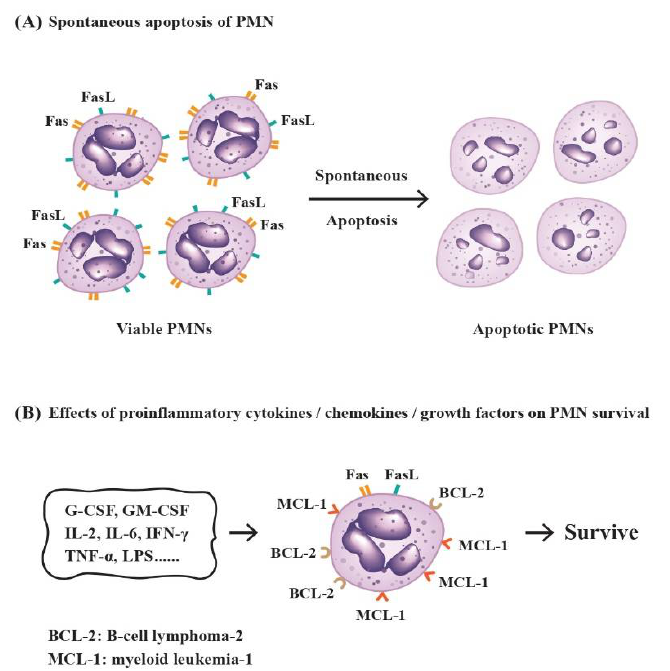
Figure 3. The molecular basis for spontaneous apoptosis and survival prolongation of PMNs by proinflammatory cytokines/chemokines/growth factors in the physiological or inflammatory envi- ronment. ( A ) Induction of spontaneous PMN apoptosis by interactions of Fas ligand (FasL) and Fas receptor (Fas, CD95) expressed on the cell surface of neighboring PMNs in normal condition; ( B ) The lifespan of PMNs can be prolonged by inflammation-related factors in the environment via increased expression of survival molecules BCL-2 and